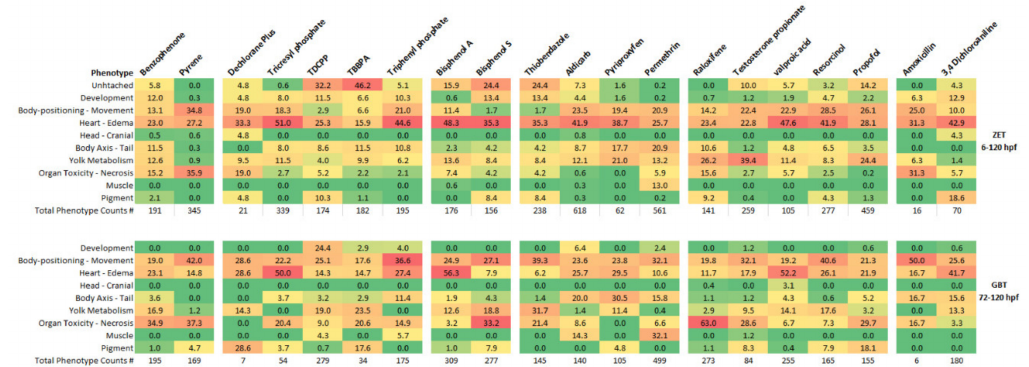
Figure 3. Prevalence of phenotypic groups observed in the ZET (6–120 hpf) and GBT (72–120 hpf) larval toxicity assays for each tested chemical. Phenotypic groups are described in Table 2. The values represent the percentage of times the specified phenotype was observed for all the phenotypic observations of all exposure replicates for each compound. Values are color coded from highest percentage to lowest percentage as red to orange to yellow to green. The total number of phenotypic counts observed for each tested chemical is listed below each column. Note: low phenotypic counts for larvae exposed to Amoxicillin and Dechlorane Plus in both